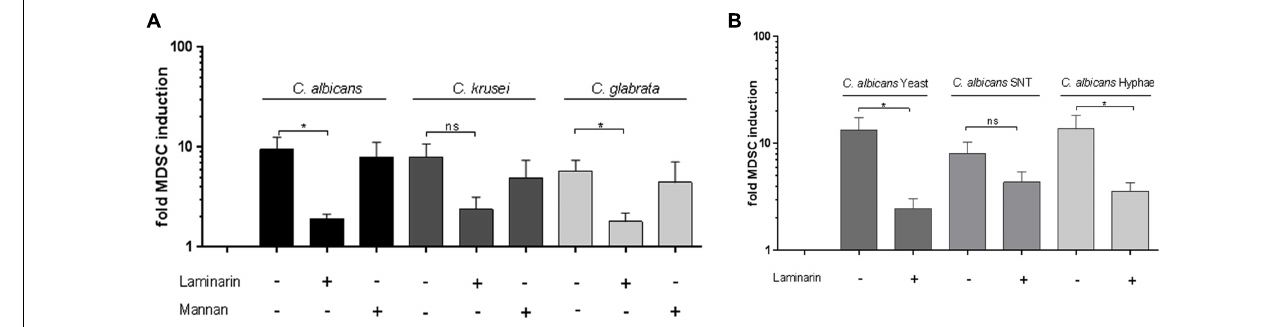
FIGURE 3 | Dectin-1 is involved in Candida -mediated MDSC induction in vitro . MDSCs were generated in vitro by incubating isolated PBMCs (5 × 10 5 cells/ml) with stimulants and inhibitors. (A) with heat killed yeast cells of C. albicans , C. krusei , and C. glabrata (all 1 × 10 5 /ml), ( n = 8–11) or (B) with heat killed C. albicans yeast cells (1 × 10 5 /ml), filter sterilized C. albicans yeast cell supernatant (5% SNT) or C. albicans hyphae for 6 days ( n = 8–13). Where indicated, prior to stimulation, PBMCs were pretreated for 60 min with Dectin-1 inhibitor Laminarin (100 µ g/ml) or Mannan (100 µ g/ml) from Saccharomyces cerevisea to